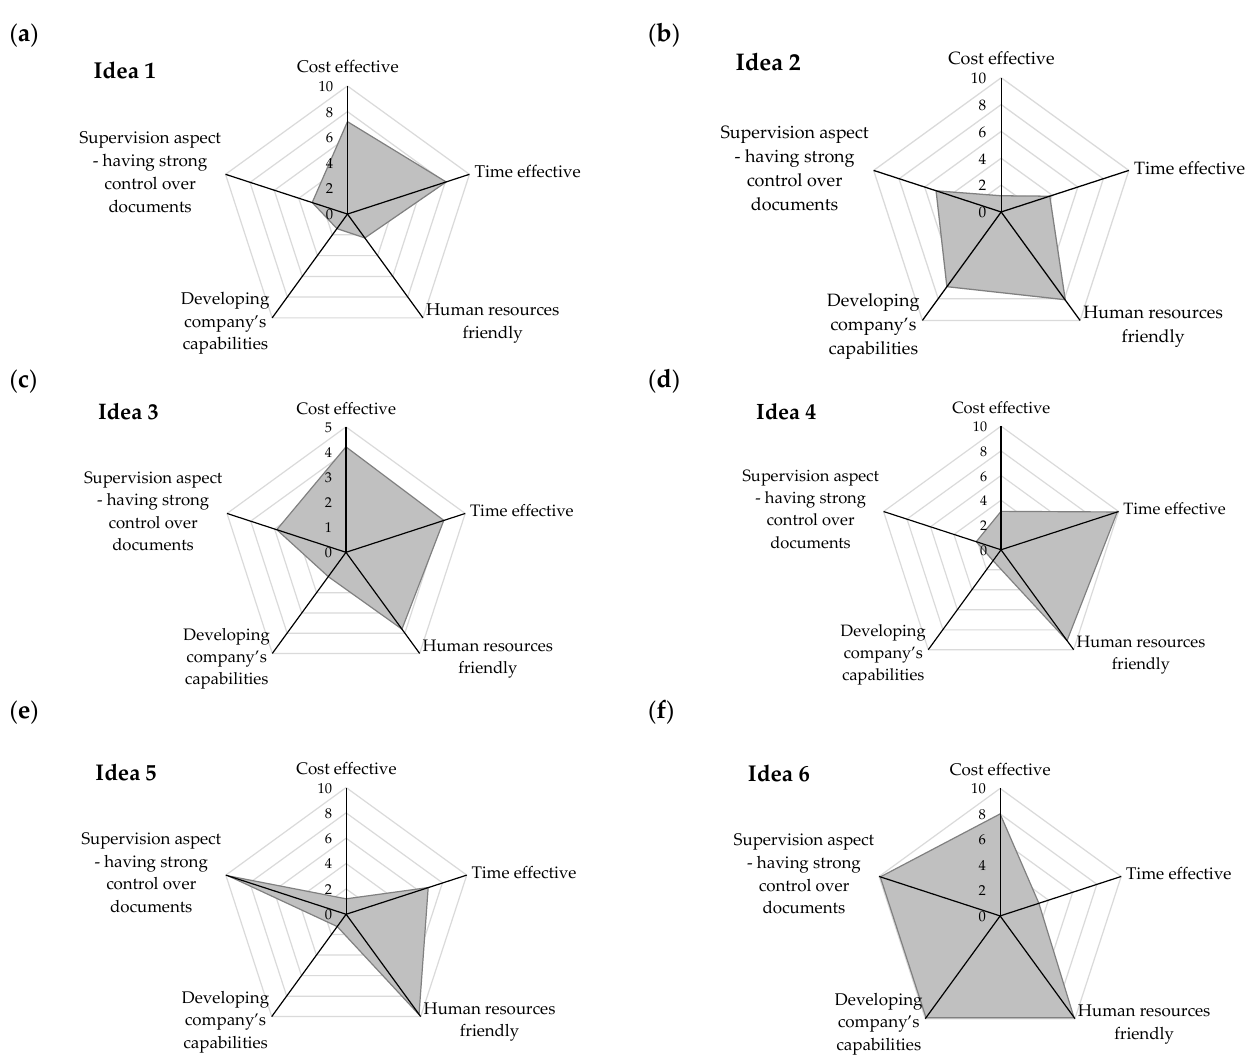
Figure 3. The detailed results of evaluation process among main stakeholders of the company: ( a ) Idea 1; ( b ) Idea 2; ( c ) Idea 3; ( d ) Idea 4; ( e ) Idea 5; ( f ) Idea 6.